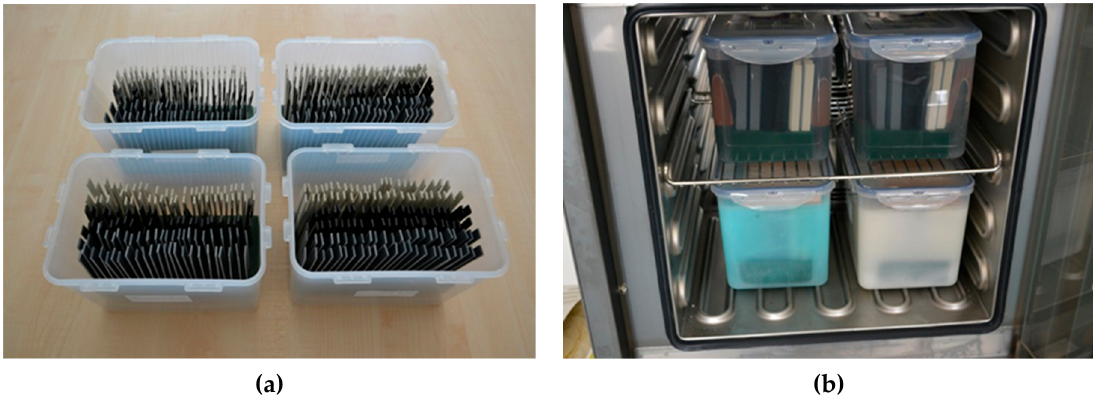
Figure 8. Plastic samples in the test beakers: ( a ) Samples before immersion in PCM and thermal cycling; ( b ) Samples immersed in PCMs placed in small environmental chamber during testing.